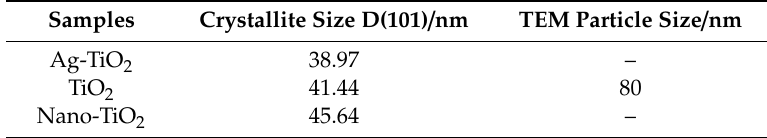
Figure 3. XRD patterns of di ff erent TiO 2 ( a ) nano-TiO 2 , ( b ) TiO 2 , and ( c ) Ag-TiO 2. Table 1. Summary of physical properties of TiO 2